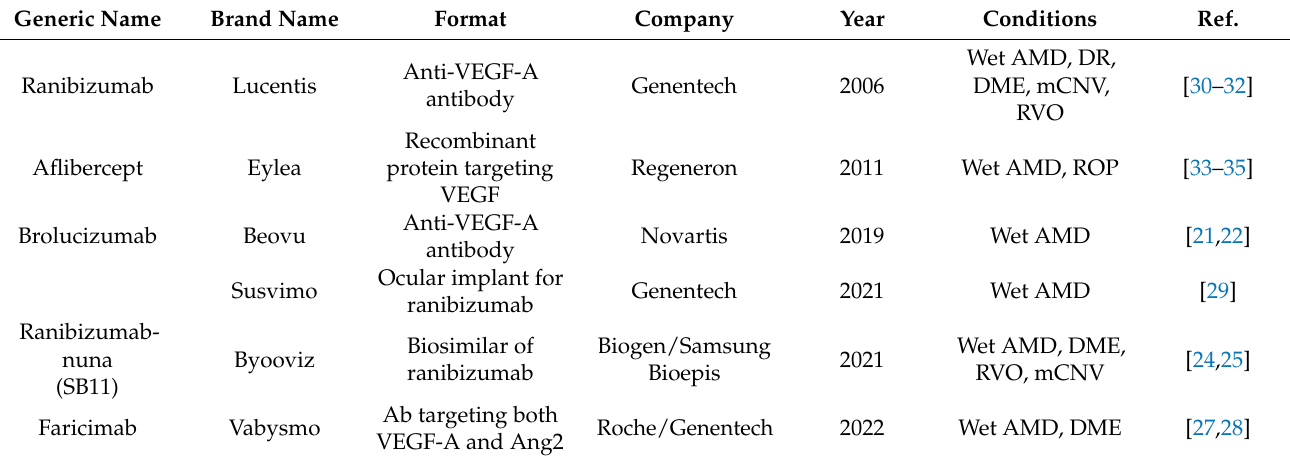
Table 1. FDA-approved therapies for eye